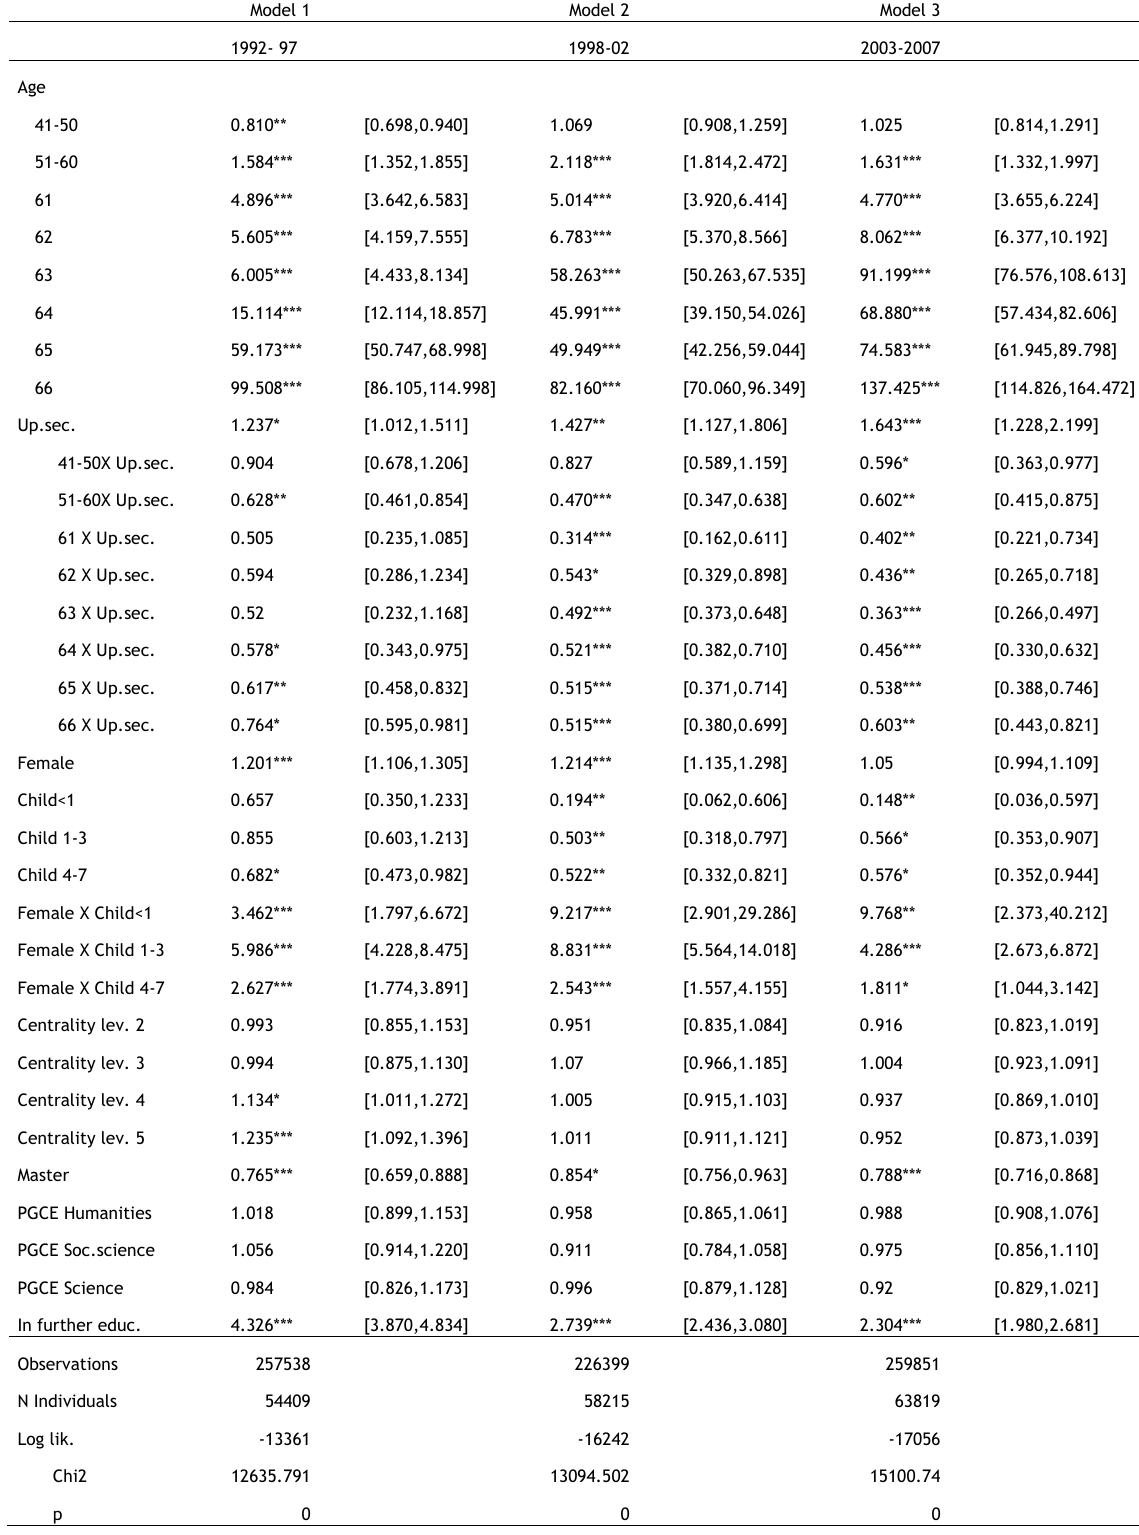
Retirement-exits. Poisson regression with cluster robust SE, exponentiated coeffi- cients. Dependent variable: Not employed. Reference is GTE graduate, age 40 or younger, employed in primary/lower secondary, male, no children<8, low centrality municipality, not in further education, no master’s degree. Separate models for dif- ferent